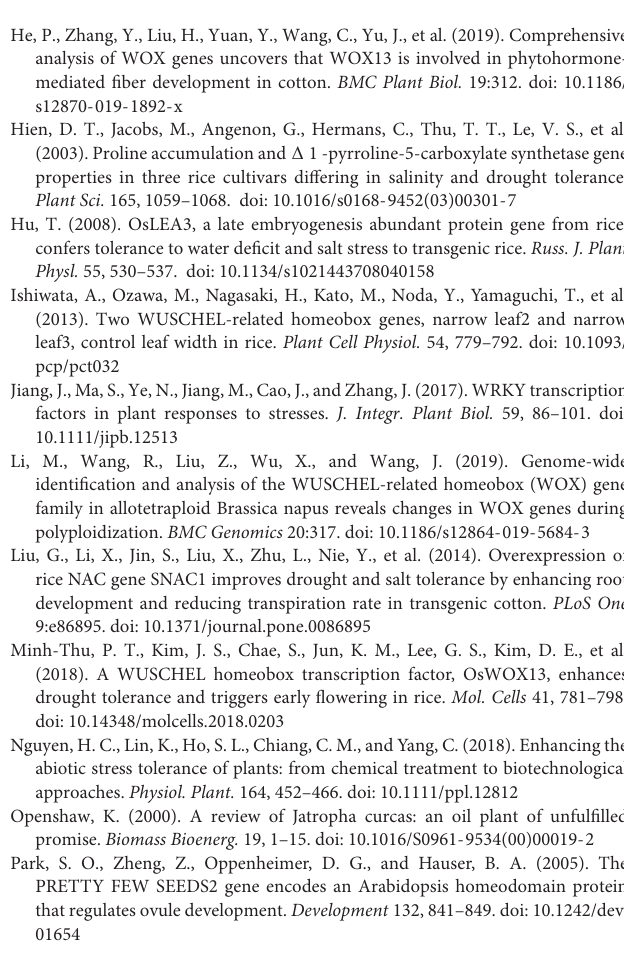
FIGURE S1 | Sequence alignments of HD domains of representative WOX proteins in physic nut carried out using the DNAMAN6.0 program. The complete conserved amino acid residues of WOX were labeled with an asterisk. FIGURE S2 | Neighbor-joining unrooted tree of WOX proteins from physic nut and Arabidopsis . Bootstrap values were calculated for 1000 replicates, and values are indicated at the corresponding nodes. FIGURE S3 | Motifs analysis of WOX proteins in physic nut. The differently colored boxes represent different motifs. TABLE S1 | Primers used in this study. TABLE S2 | Summary of JcWOX genes encoding WOX proteins in physic